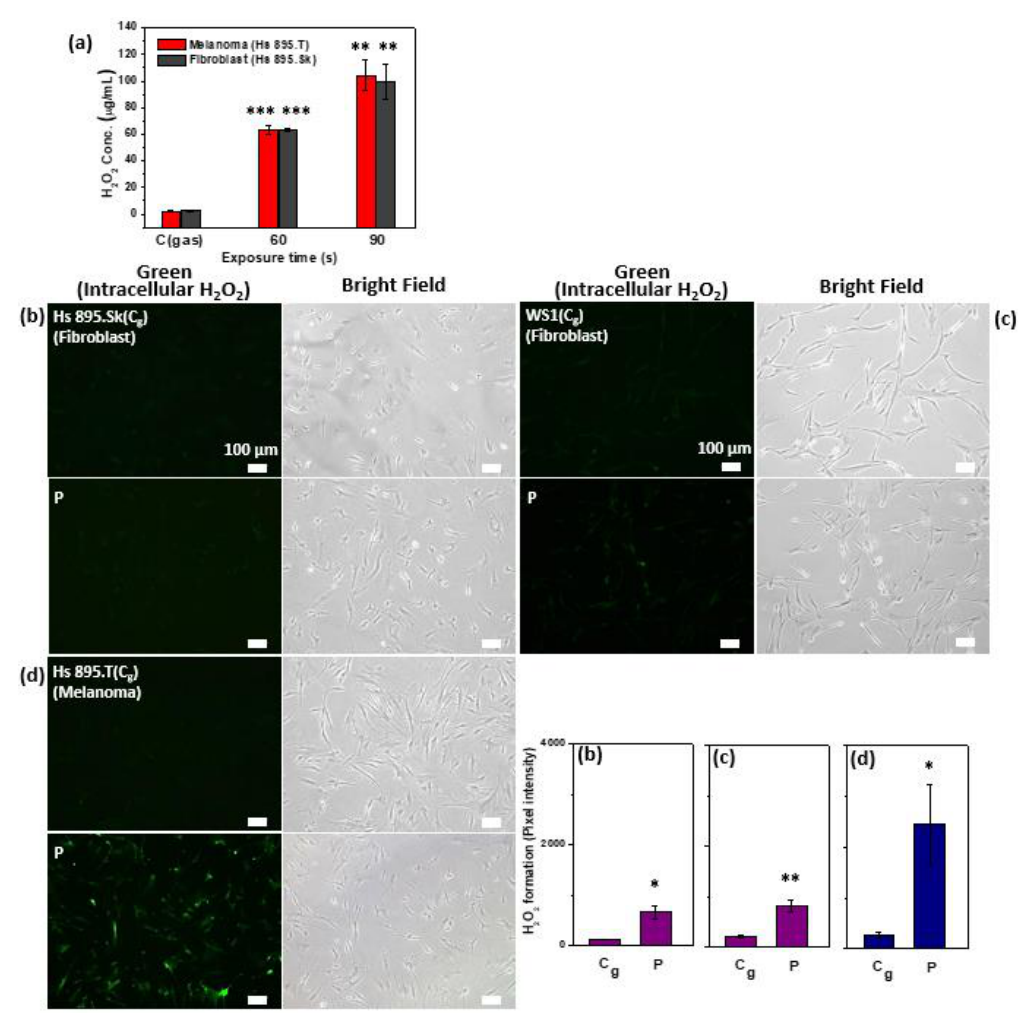
Figure 5. CAP induces the increased level of intracellular hydrogen peroxide (H 2 O 2 ) in cancer cells. ( a ) Extracellular hydrogen peroxide (H 2 O 2 ) concentration as a function of treatment time in the presence of cancer (Hs 895.T: melanoma) and non-cancerous (Hs 895.Sk: fibroblasts) cells. Fluorescence images and intensity graphs of intracellular H 2 O 2 production and brightfield images in non-cancerous (( b ) Hs 895.Sk, ( c ) WS1), and ( d ) melanoma (Hs 895.T) cells (upper row of figure, gas-treated control; bottom row of figure, CAP-treated cells). Green images represent the detection of intracellular H 2 O 2 . Each point represents the mean ± SD of three replicates. Scale bar indicates 100 μm. *, p < 0.05; **, p < 0.01; ***, p < 0.001. * p < 0.05 was considered statistically significant.